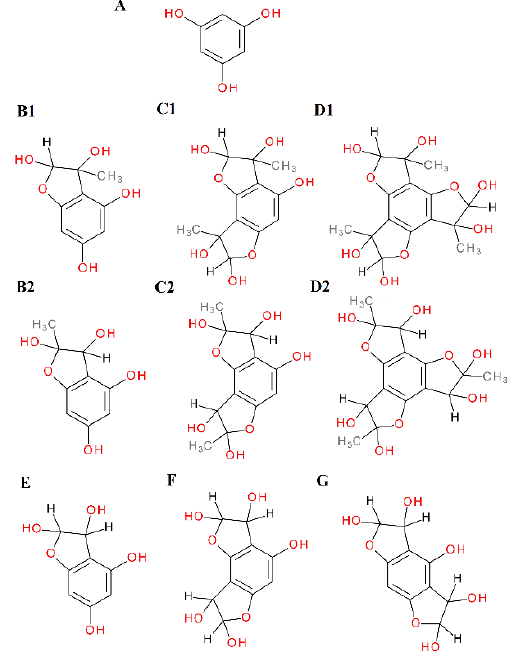
Figure 3. Proposals for chemical structures of adducts formed in the reaction of phloroglucinol with methylglyoxal/glyoxal after 1 h of incubation in pH 7.4 phosphate buffer solution at 37 °C; ( A ), phloroglucinol; ( B1 ), hemiacetal form of mono-MGO-phloroglucinol; ( B2 ), hemiketal form of mono-MGO-phloroglucinol; ( C1 ), hemiacetal form of di-MGO-phloroglucinol; ( C2 ), hemiketal form of di-MGO-phloroglucinol; ( D1 ), hemiacetal form of tri-MGO-phloroglucinol; ( D2 ), hemiketal form of tri-MGO-phloroglucinol; ( E ), mono-GO-phloroglucinol; ( F ), di-GO-phloroglucinol isomer a; ( G ), di-GO-phloroglucinol isomer b. Other isomers are also possible.